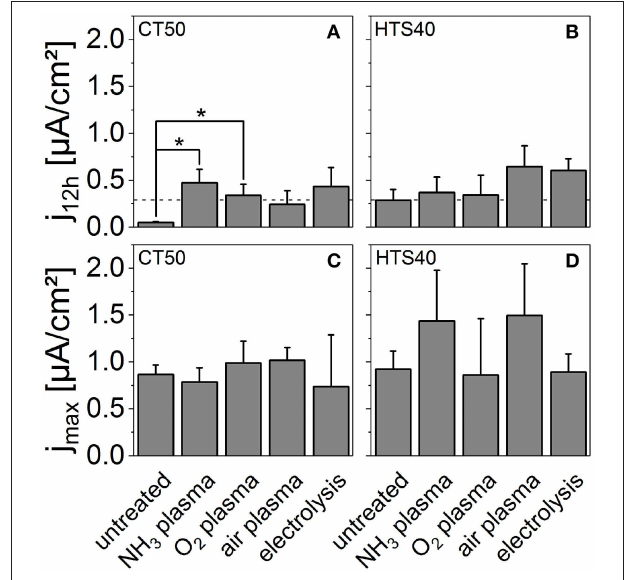
FIGURE 3 | Performances of single carbon fiber electrodes CT50 (A,C) and HTS40 (B,D) ; influence of different surface activation methods on startup current density (A,B) and maximum current density (C,D) , both normalized to filament surface area (300 cm ² ). Non-activated controls are only desized. The j 12h level of the untreated HTS40 control is indicated by the dashed horizontal line. Asterisks mark significance levels with p < 0.05 (Welch corrected two-sampled t